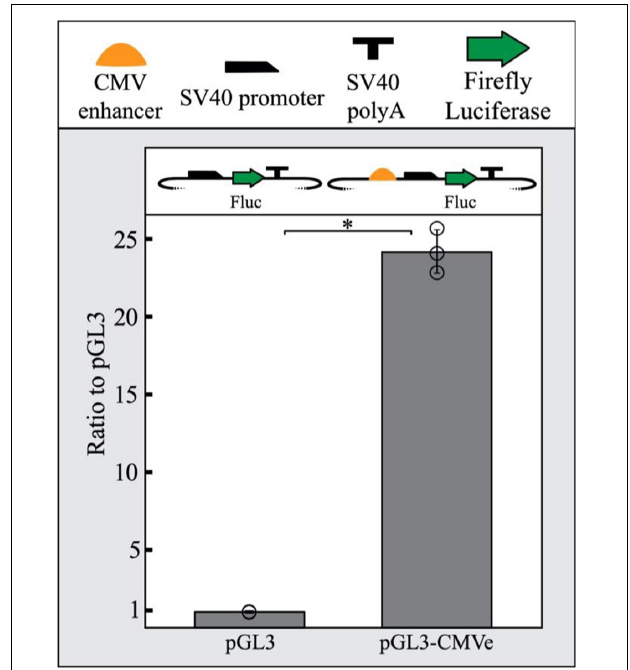
FIGURE 1 | The CMV enhancer drives strong reporter gene expression in PAC2 cells. The CMV enhancer shows a 24-fold increase in luciferase activity in PAC2 zebrafish fibroblast cells compared to a SV40 promoter-only plasmid. Error bars represent standard deviation of 3 biological replicates. Statistical significance was determined using a Student’s two tailed t -test ∗ P < 0.01. Points represent values for all 3 replicates in each condition. All plasmid components are detailed as symbols above the figure. The TSS starts where the SV40 promoter begins to slope downward.